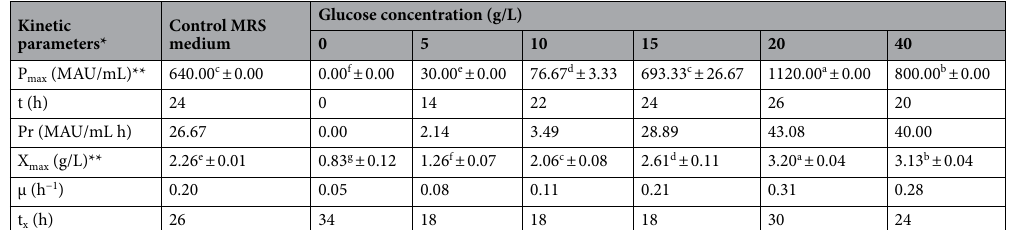
Table 3. Effect of glucose concentrations on the growth and antimicrobial activity of postbiotic RS5 produced by L. plantarum RS5. *P max (MAU/mL)—maximum antimicrobial activity, t (h)—cultivation time of maximum antimicrobial activity, Pr (MAU/mL h)—productivity of antimicrobial activity, X max (g/L) —maximum biomass, µ (h −1 )—specific growth rate, t x (h)—cultivation time of maximum biomass. **Values for P max (MAU/ mL) and X max (g/L) are mean ± standard error of the mean (SEM), n = 3. Mean ± SEM within the same row that does not share a similar superscript are significantly different (p < 0.05).